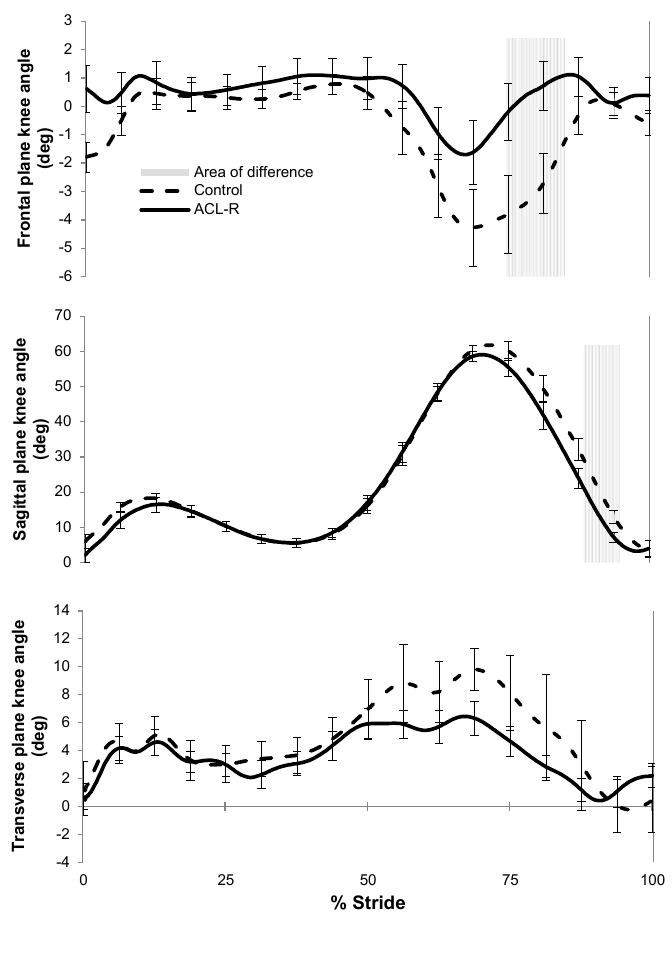
control group normalized over the stride. Segments with significant differences between the ACL-R and control groups are shown in the shaded